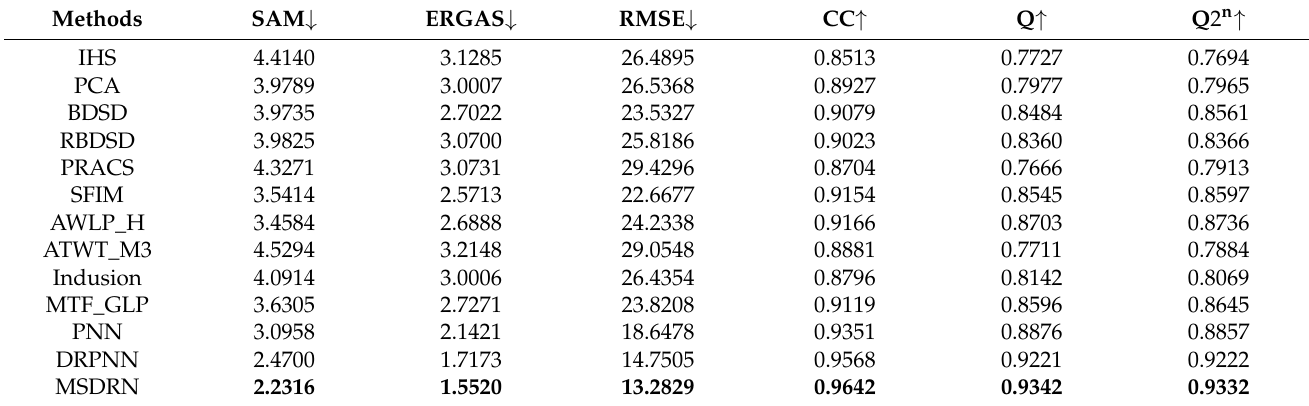
Table 4. Quantitative evaluation comparison of fusion results on the GeoEye-1 dataset.